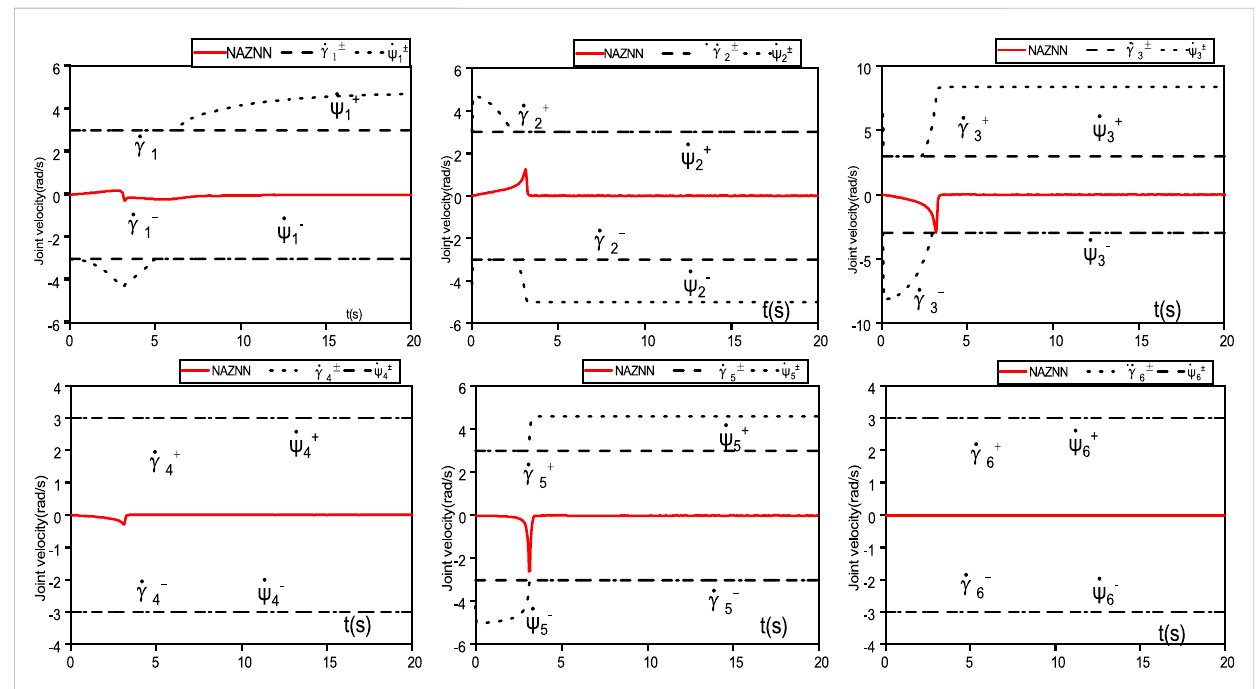
FIGURE 8 The NAZNN model-controlled wheeled robot successfully fi nishes the trajectory tracking with 6 joint velocities change.